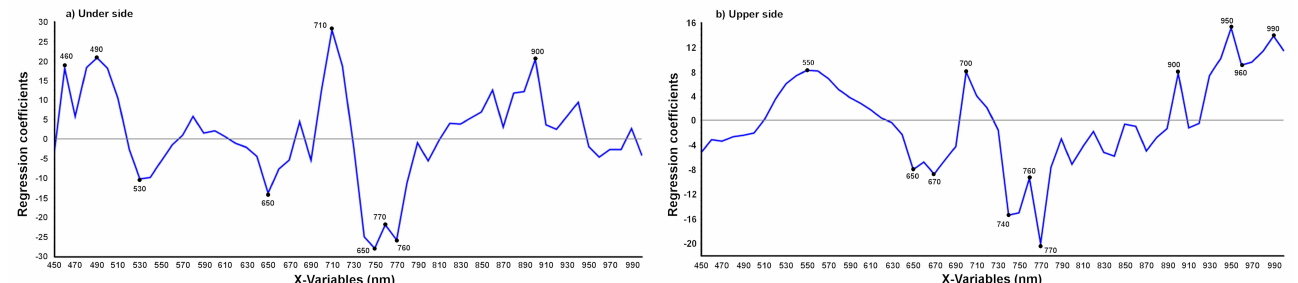
Figure 9. Vector of regression coefficients of the PLS model using mean spectra and with the optimal wavelengths selected on ( a ) under side and ( b ) upper side of the